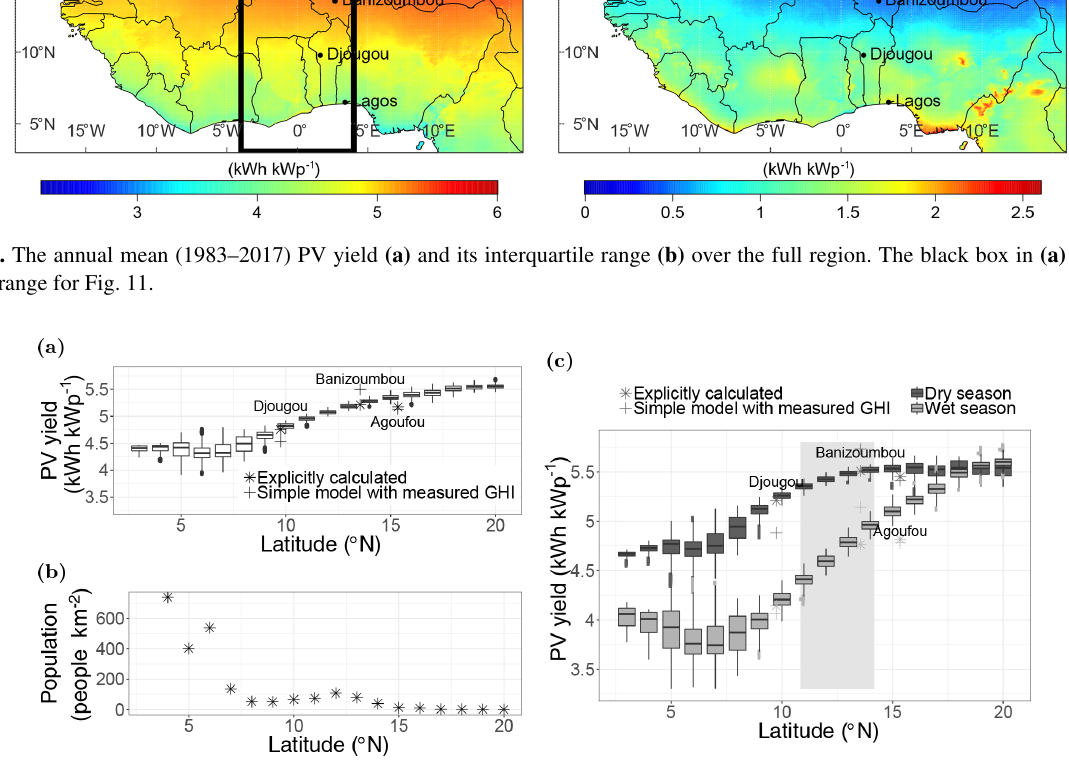
Figure 11. (a) Mean (temporal) PV yield at each latitude for the total year, ( b ) population density for each latitude (NASA, 2020), and (c) mean PV yield at each latitude for the dry season (October–April; light gray) and the wet season (May–September; dark gray) in the longitude range between 4 ◦ W and 4 ◦ E. The single points mark the temporal mean PV yield calculated with the explicit model and the measured ambient temperature (star) as well as the PV yield calculated with the simple model and the measured GHI (cross) at the three sites: Agoufou (2005–2008), Banizoumbou (2005–2012) and Djougou (2002–2009). The gray background box in (c) marks the latitude range where the definition of seasons is most